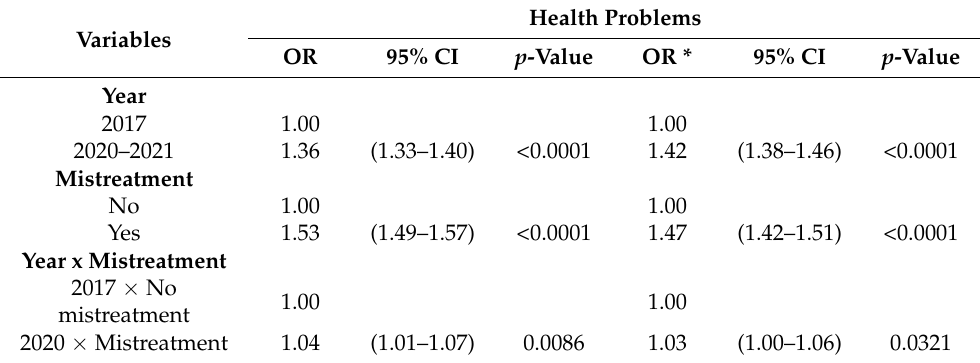
Table 4. The results of interaction factors associated with health